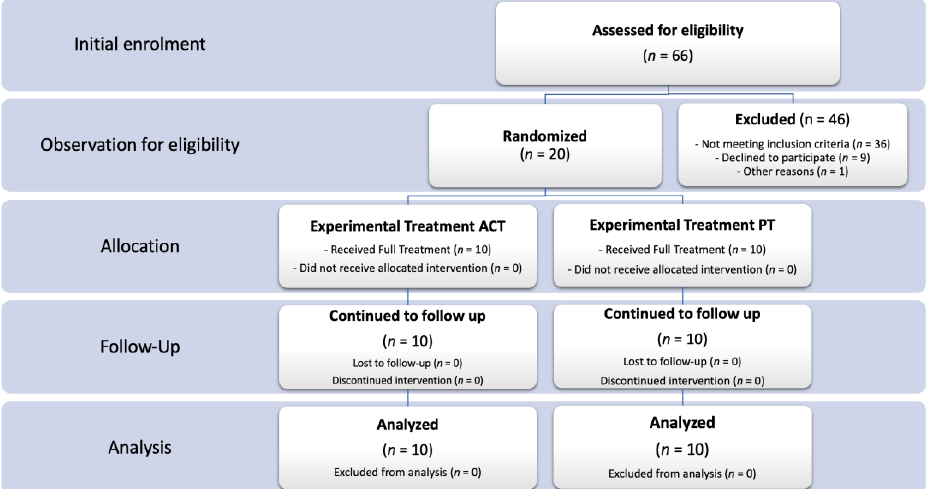
Figure 2. CONSORT Flow diagram showing the phases of a parallel randomized trial of two groups of ASD parent pairs underwent experimental (ACT: Acceptance and Commitment Therapy) or conventional (PT: Parent Training) training interventions.